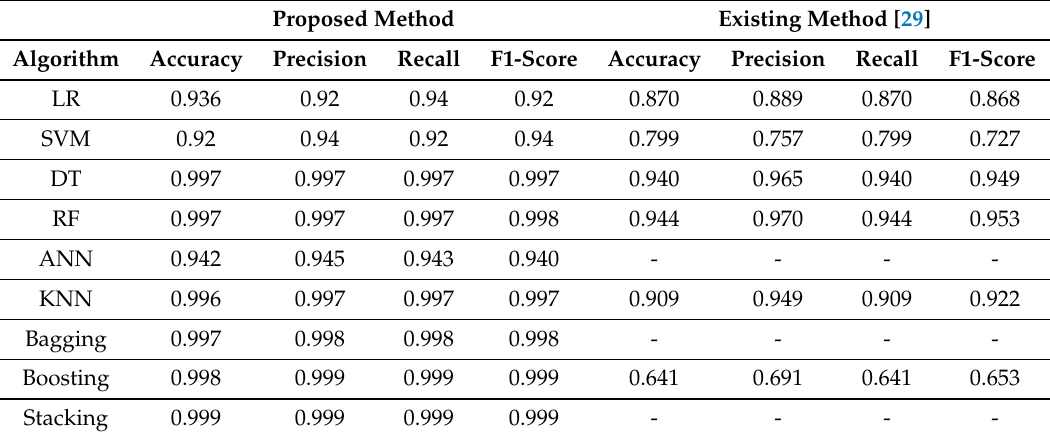
Table 8. Comparison of multi-class classification performance on CICIDS2017.